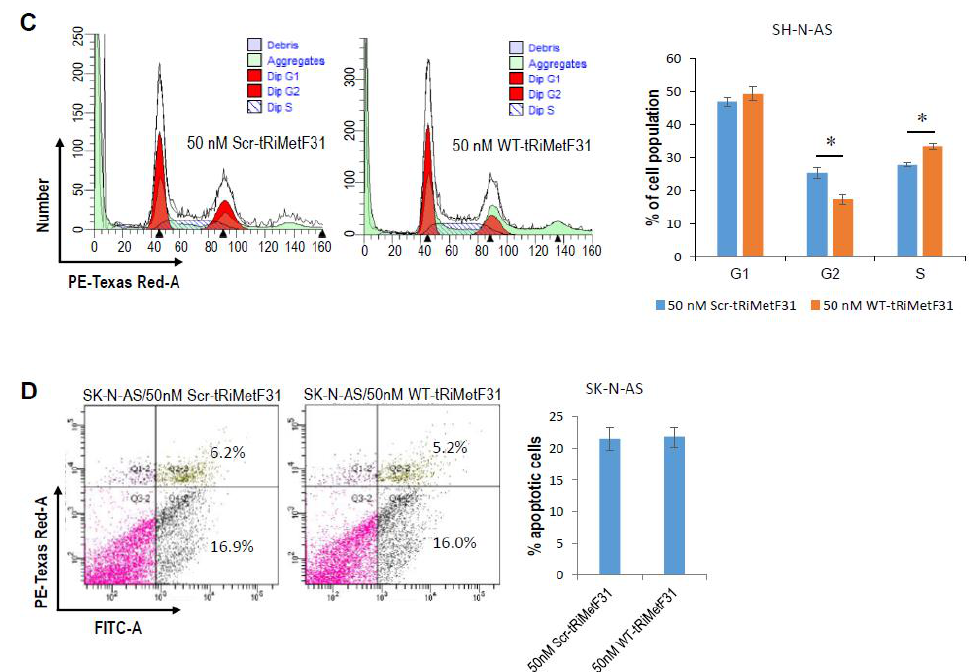
Figure 5. tRiMetF31 inhibits proliferation and induces S-phase cell cycle arrest of SK-N-AS cells. ( A ) SK-N-AS cells were transfected with 12.5, 25, or 50 nM of either WT-tRiMetF31 or Scr-tRiMetF31. At 48 h after transfection, whole cellular lysates were prepared and subjected to Western blotting with antibody to PFKFB3, and GAPDH served as a loading control. Relative densitometry was measured using ImageJ, calculated as a ratio to GAPDH, and expressed as mean ± SD for three independent measurements. ( B ) SK-N-AS cells were transfected with 25 or 50 nM of either WT-tRiMetF31 or Scr-tRiMetF31. At 24 h after transfection, cells were replated in 96-well plates, and MTT assay was performed as detailed in Section 4. ( C , D ) SK-N-AS cells were transfected with 50 nM of either WT-tRiMetF31 or Scr-tRiMetF31. At 48 h after transfection, cells were harvested for cell cycle and apoptosis analyses as detailed in Section 4. *, p < 0.05; **, p < 0.01. Original western blot data is shown in Figure